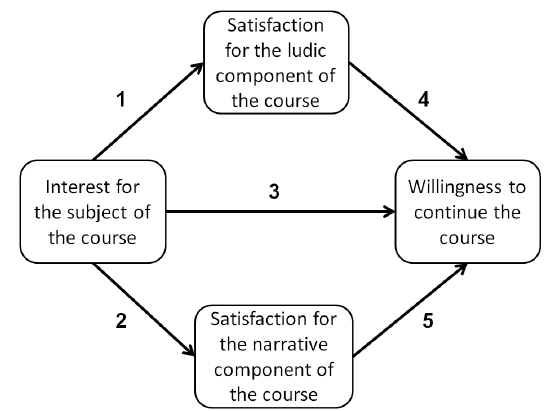
Figure 1. the complete causal Model